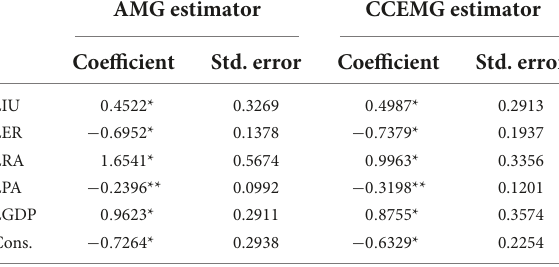
TABLE 6 Long-run outcomes of augmented mean group (AMG) and CCE-MG estimators.